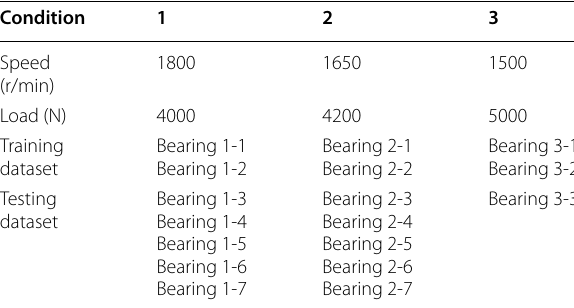
Table 2 Bearing dataset with operational